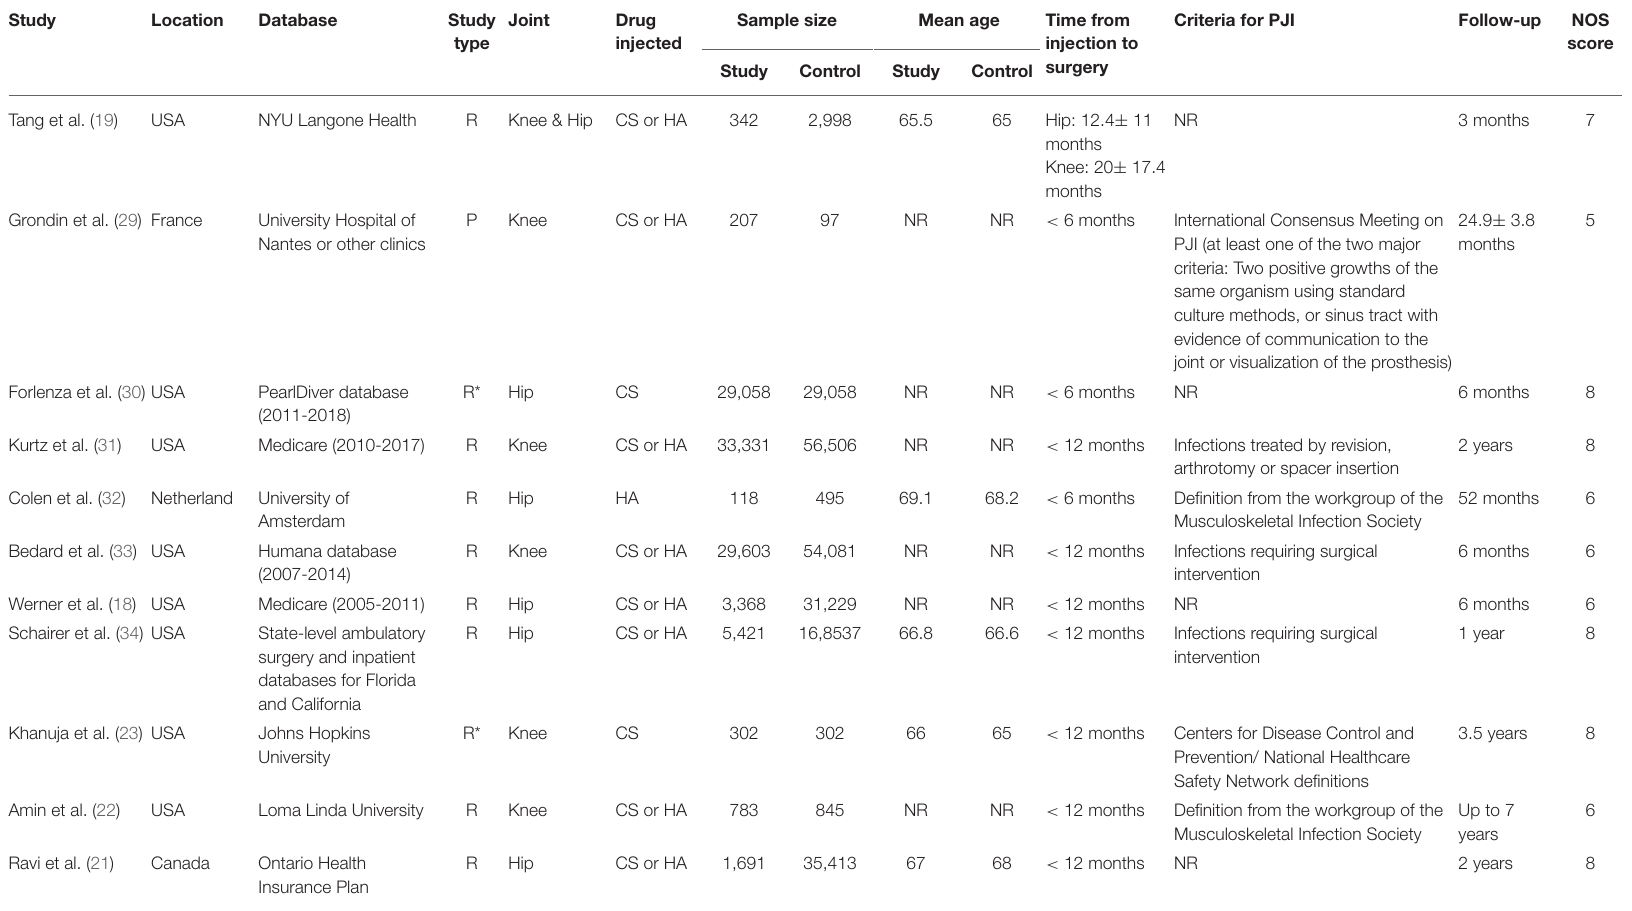
TABLE 1 | Details of included